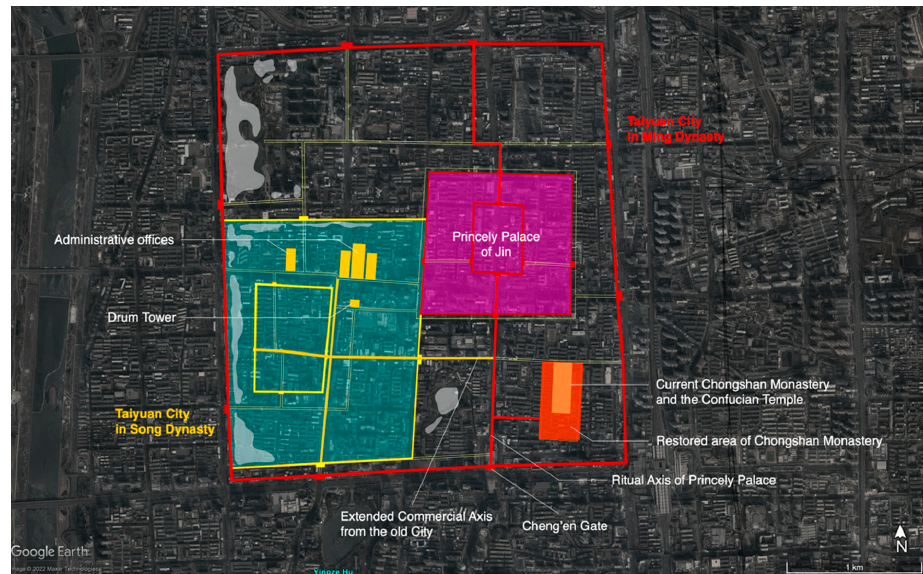
Figure 6. The functional distribution of Taiyuan City in the Ming Dynasty (drawing by author, after (Ma et al. 2013, p. 43), Figures 2.1–4, based on Google Maps 2022). It is the east–west axis before the Pailiang Gate depicted in the Plan that led Chongshansi to the New South Gate Street. Ming princes were obliged to represent the emperor’s authority in the regions assigned to them and pray for the empire and their principalities via Buddhist rituals (Luo 2013). In the existing documents, descriptions are lacking for how the Princes of Jin performed rituals in Chongshansi. However, the Great Shuilu Assembly 水陸法會 held by Emperor Hongwu in the capital Nanjing may pro- vide a reliable reference. This ceremony is usually held after war to redeem lost souls from hell by chanting sutras and making offerings. From the first year to the fifth year of the Hongwu period (1368–1372), Emperor Hongwu convoked several great ceremonies in Jiangshansi in Nanjing. Among them, the one held in January of the fifth year was of the biggest scale and the highest rank. The details of the ceremony were documented by Song Lian 宋濂 in Jiangshan Guangjian Fohui Ji 蔣山寺廣薦佛會記 : “the emperor came to the Fengtian Front Hall 奉天前殿 , the main audience hall of the imperial palace, accompanied by the officers. Here, the prayer, written and stamped by the emperor, was sealed and given to the Chief Officer Tao Kai 陶凯 from the Ministry of Rites. Tao walked out of the palace through the central Wu Gate 午門 and took the prayer into the dragon carriage, via which it was sent to the Jiangshansi with guards and an orchestra. It was greeted by the monks of the Great Buddha’s Hall.” (see Du 2013; He 2013, pp. 354–56). In the early Hongwu period, Taiyuan was a place full of military conflicts and bloody battles where Prince Gong himself led the army to fight with the Mongol troops. It was reasonable for him to hold such great ceremonies there, as Emperor Hongwu did in Jiangshansi. Accord- ingly, we could speculate a ritual program that began with the prince’s procession from the Nanhua Gate 南華門 , the south gate of this palace, toward the south, before turning east, going through the west side gate, stopping before Pailiang Gate, and then entering the temple along the central axis. In Chengchi tu 城池圖 (map of the city) in the 1682 gazetteer of Yangqu county, the street directly connecting Chongshansi and the New South Gate Street is clearly depicted. In Jiexiang tu 街巷圖 (map of streets and lanes) of the 1843 gazetteer of Yangqu county, the temple is found facing west, intuitively revealing the west as the key position and reflecting the description of political space in the traditional Chinese map (Figure 7).